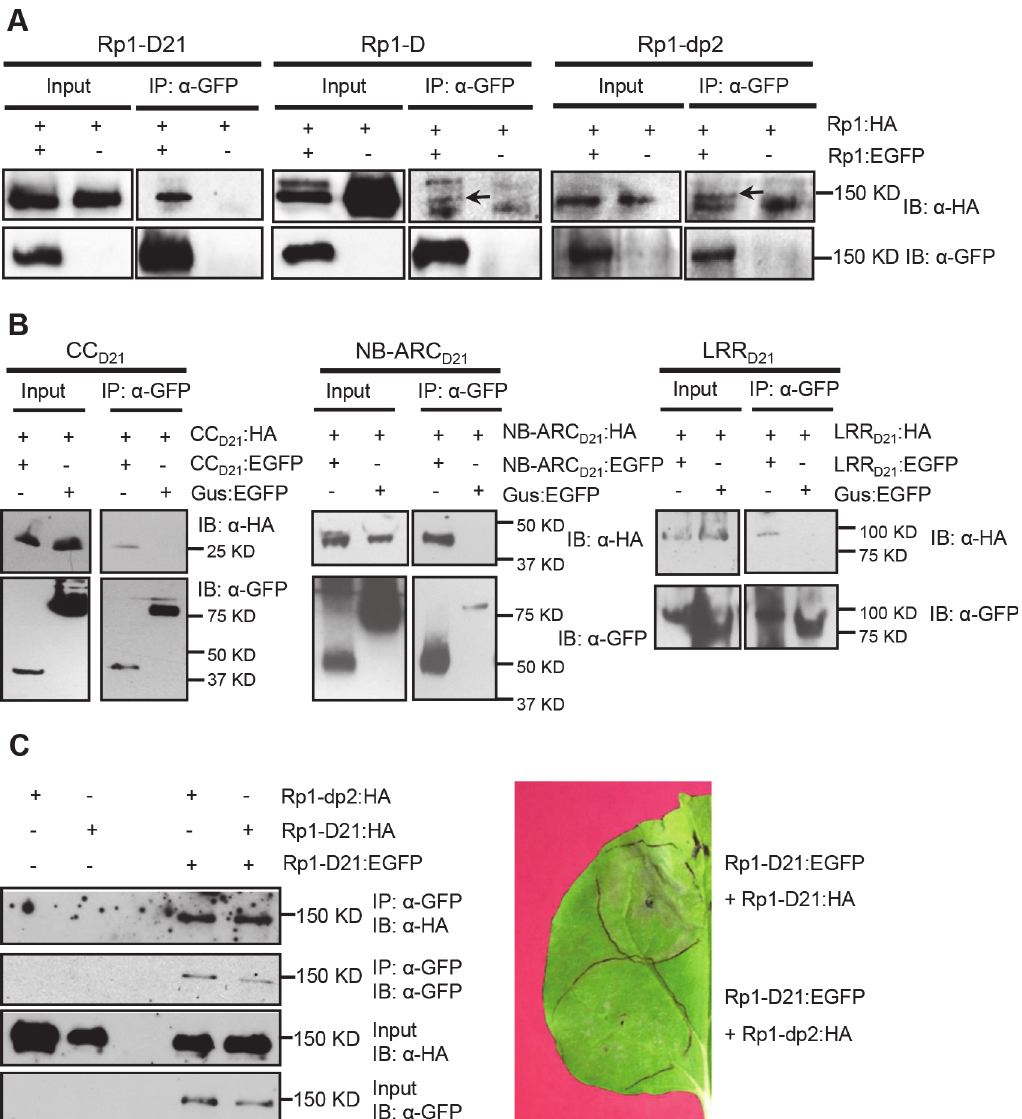
Fig 9. Investigation of self-association of full length Rp1-D21, Rp1-D, Rp1-dp2, the separate domains of Rp1-D21, and the interaction of full length Rp1-D21 with Rp1-dp2. (A) Self-association of 3×HA- and EGFP-tagged Rp1-D21 (left panel), Rp1-D (middle panel) and Rp1-dp2 (right panel). Arrows indicate the target bands. (B) Self-association of CC D21 , NB D21 and LRR D21 . (C) Left: Co-IP after co-expression of Rp1-D21 and Rp1-dp2. Right: HR induced by co-expression of Rp1-D21:EGFP with Rp1-D21:HA compared to HR induced by co-expression of Rp1-D21:EGFP with Rp1-dp2:HA. EGFP- and 3×HA- tagged constructs were transiently co-expressed in N . benthamiana and samples were collected at 30 hours post infiltration for Co-IP assay. Protein extract was immunoprecipitated by anti-GFP microbeads and detected by anti-GFP and anti-HA antibodies. The experiments were repeated three times with the same